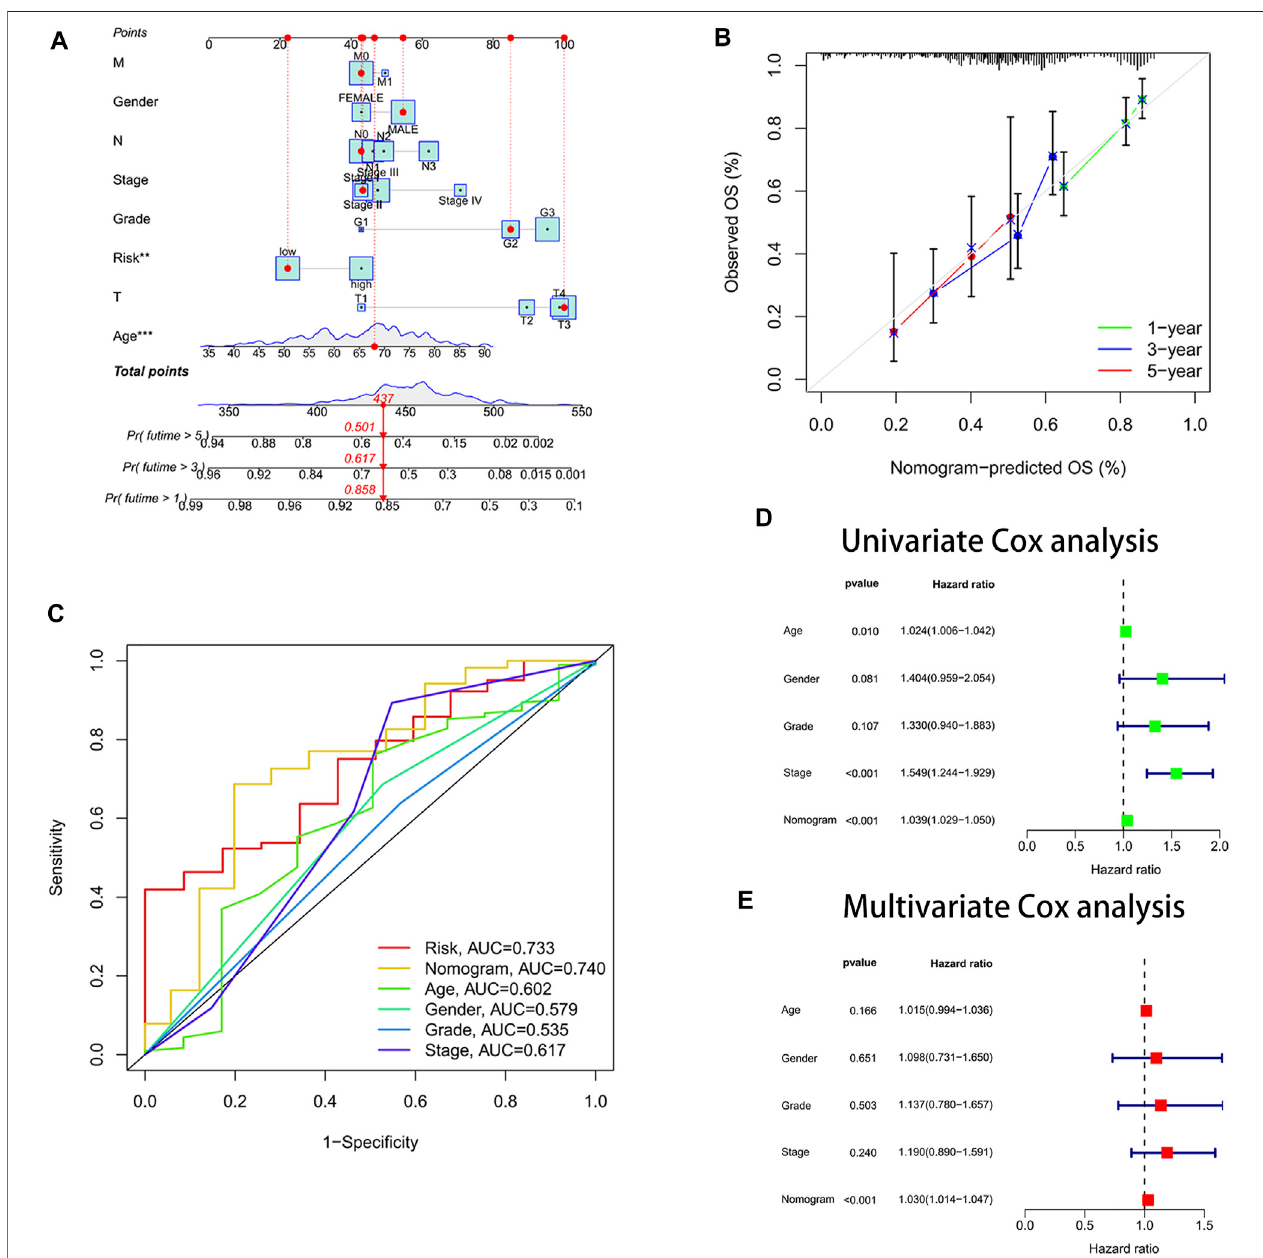
FIGURE 4 | Constructed a nomogram for predicting survival. (A) Nomogram. (B) Calibration curves. The y-axis is the actual survival rate, and the x-axis is the predicted survival rate. (C) Area under the ROC curve (AUC) of the nomogram. (D) Univariate Cox analysis. (E) Multivariate Cox analysis.